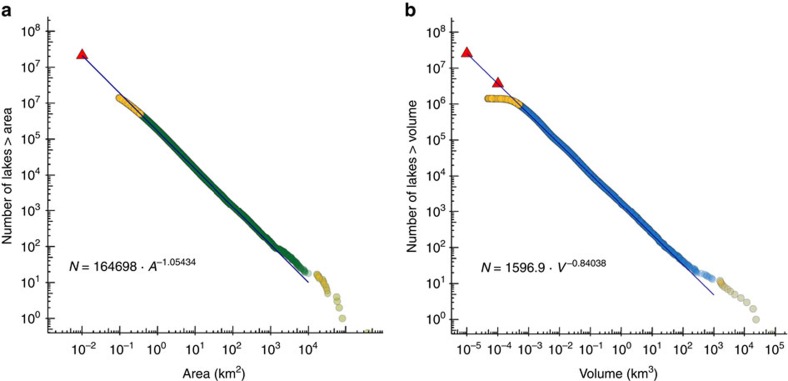
Global size and volume distributions of natural lakes using a Pareto model.Distributions are plotted as the total number of global lakes larger than a given surface area (a) or volume (b) derived from data contained in HydroLAKES. Yellow points represent data that were not included for fitting the log–log regression. Red triangles represent extrapolated values based on the log–log regression. See Methods for further explanations.